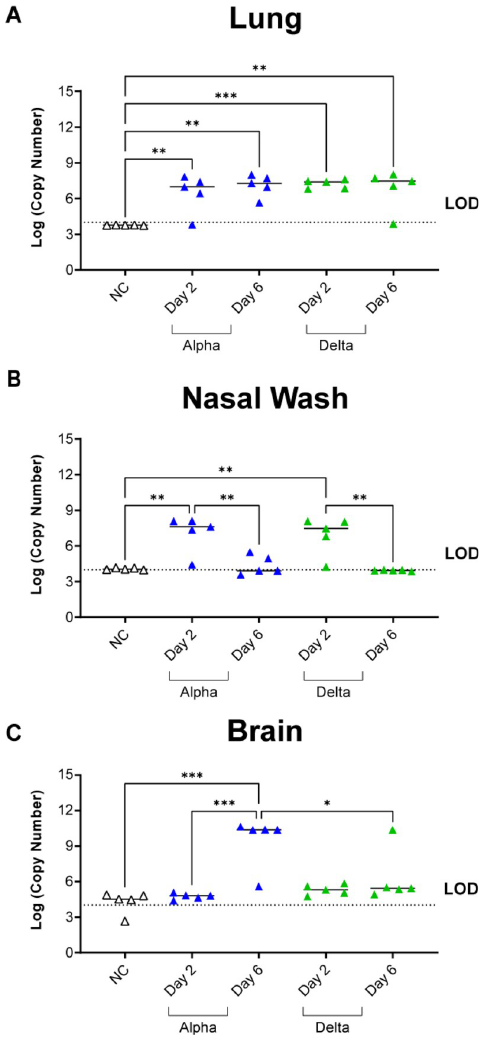
Fig 2. Viral RNA burden of disease-associated tissues was quantified using nucleocapsid qPCR. Viral RNA was detectable in the lung tissue of challenged mice from both variants at both timepoints compared to no challenge (One- Way ANOVA, left to right: P = 0.0082, 0.0011, 0.0008, 0.0029) (A). In Nasal Wash, viral RNA burden increased from both variants at Day 2 compared to no challenge (One-Way ANOVA, P = 0.0016 Alpha; P = 0.0030 Delta) and was decreased at Day 6 for both variants from copy numbers at Day 2 (One-Way ANOVA, P = 0.0043 Alpha; P = 0.0019 Delta) with no statistical difference between variants at each time point (B). Alpha-challenged mice have increased detectable viral RNA in the brain at Day 6 compared to Day 2 (One-Way ANOVA, P = 0.0005) while Delta challenge results in no viral RNA burden in the brain (One-Way ANOVA: P = 0.0002 NC vs Alpha Day 6, P = 0.0228 Alpha Day 6 vs Delta Day 6) (C). Dashed lines indicate limit of detection (LOD) via qPCR. NC = no challenge. Data is representative of n = 5 mice per experimental group. Delta only resulted in one mouse with detectable viral RNA in the brain at day 6 (Fig 2C). In contrast, mice infected with Alpha exhibited low RNA levels at day 2 and a 2-fold increase at day 6, suggesting an increase in viral replication in the brain over time (Fig 2C). These obser- vations suggest that Delta at a challenge dose of 10 3 PFU replicates efficiently in the airway in a manner similar to Alpha but Delta appears to have lower brain localization previously observed in K18-hACE2-mice [41, 44–46].